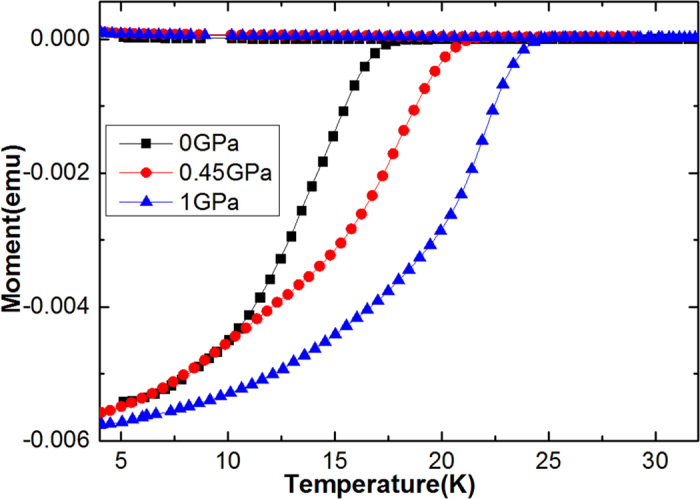
Temperature dependence of magnetic moment at different applied pressures in both ZFC and FC runs for NaFe0.97Co0.03As.